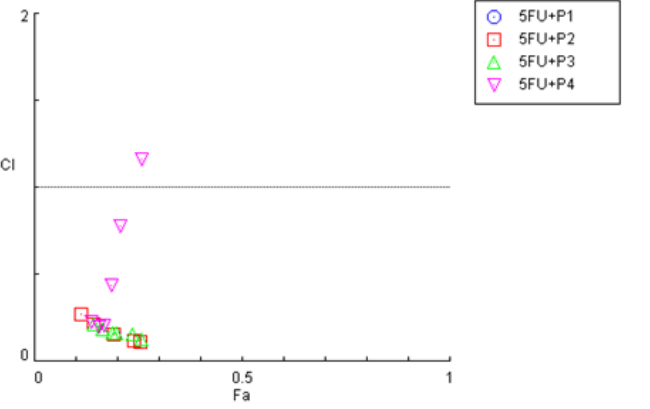
Figure 23. Effect level – combination index (Fa-CI) plot obtained for HT-29 cells after exposure to the combination of 5-FU with increasing concentrations of the peptides P1 – P4, obtained using the Chou – Talalay method. CI < 1 — synergism; CI = 1 — additivity CI > 1 — antagonism.